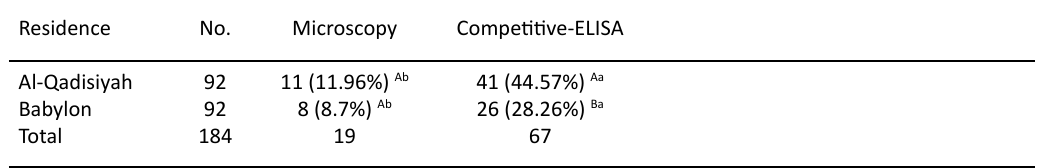
Table 3. Association of positive A. marginale infections to